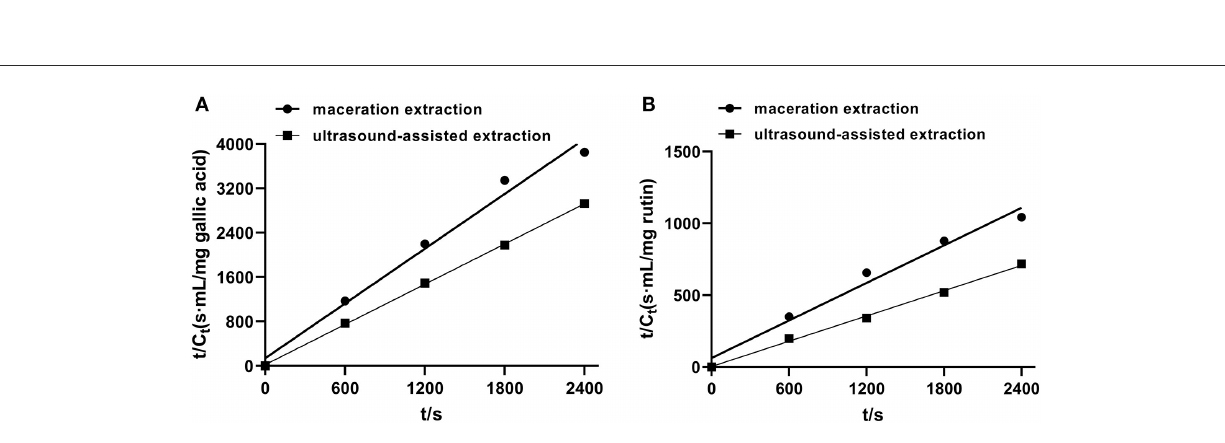
FIGURE4 The second-order extraction kinetics of propolis extraction with maceration and ultrasound-assisted approach. (A) TPC; (B) TFC.